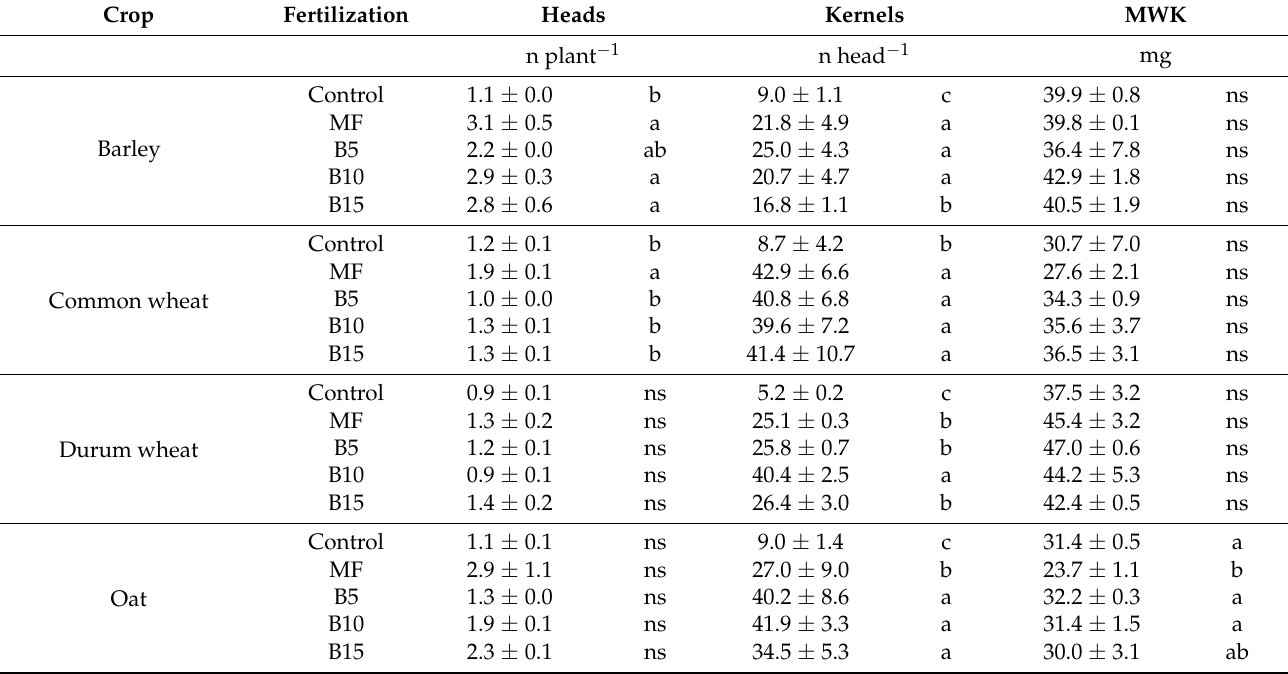
Table 4. Yield components of cereals, as affected by fertilization treatment in barley, common wheat, durum wheat, and oat. Crop